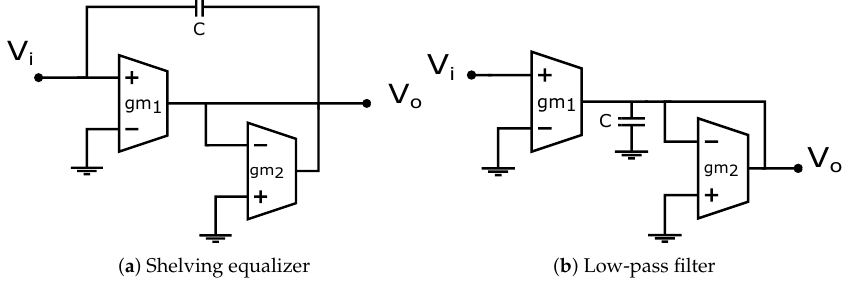
Figure 4. OTA-based first-order active filters taken from [33], to implement: ( a ) H 1 ( s ) and H 2 ( s ) , and ( b ) H 3 ( s )